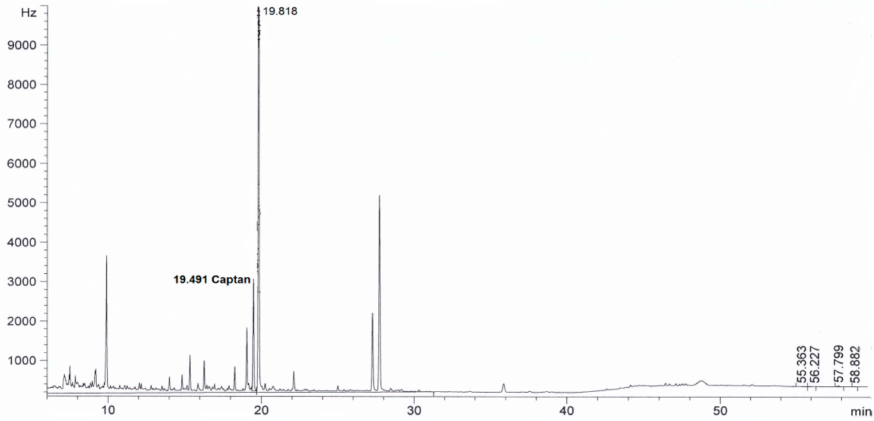
Figure 2. The chromatogram (GC- µ ECD) of industrial wastewater without the clean-up step using the dispersive solid phase extraction technique (dSPE).